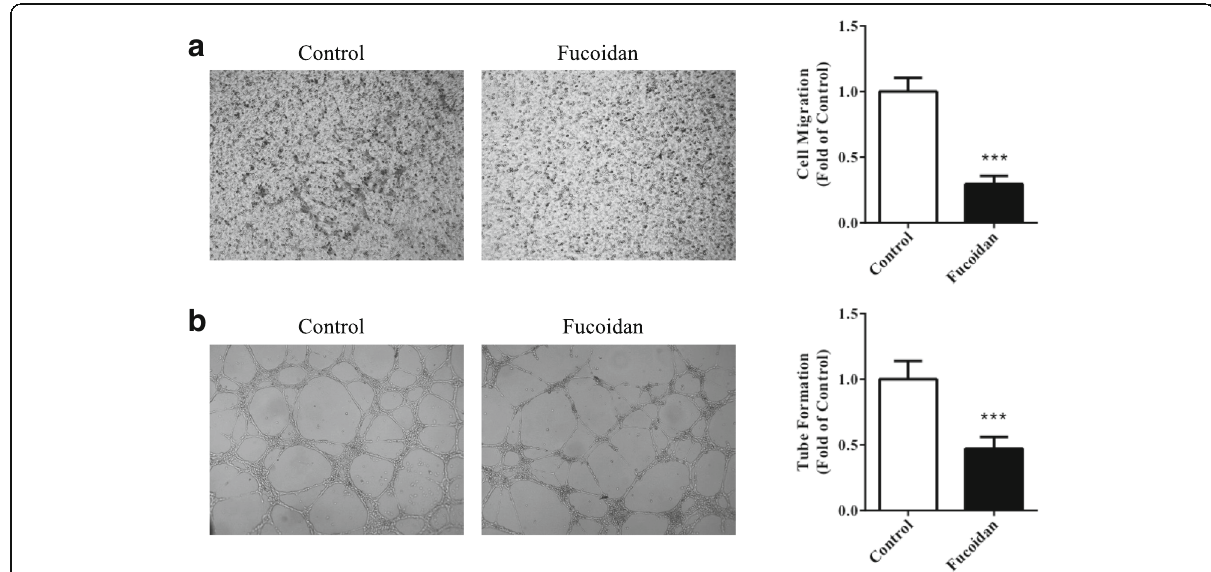
Fig. 2 Fucoidan inhibited migration and tube formation of prostate cancer cells. a DU-145 cells were seeded into Transwell and treated with fucoidan (500 μ g/mL) for 12 h. b DU-145 cells were seeded into Matrigel and treated with fucoidan (500 μ g/mL) for 6 h. *** P < 0.001 vs. control. All experiments were repeated at least three times